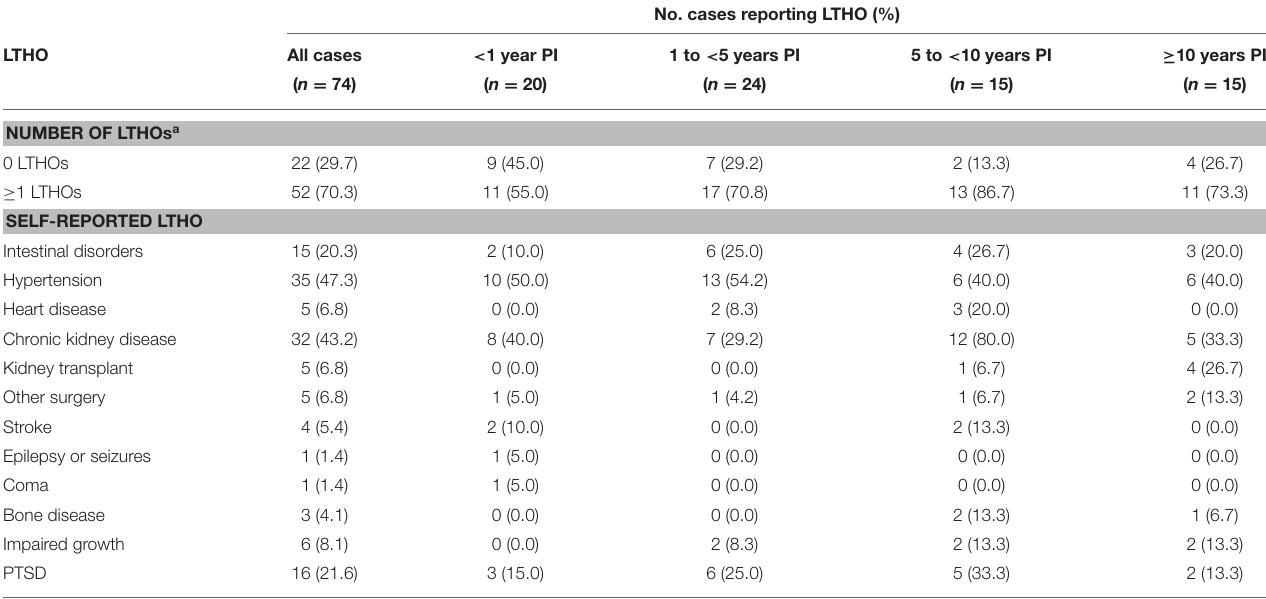
TABLE 4 | Report of long-term health outcomes among HUS cases by length of time since acute illness.